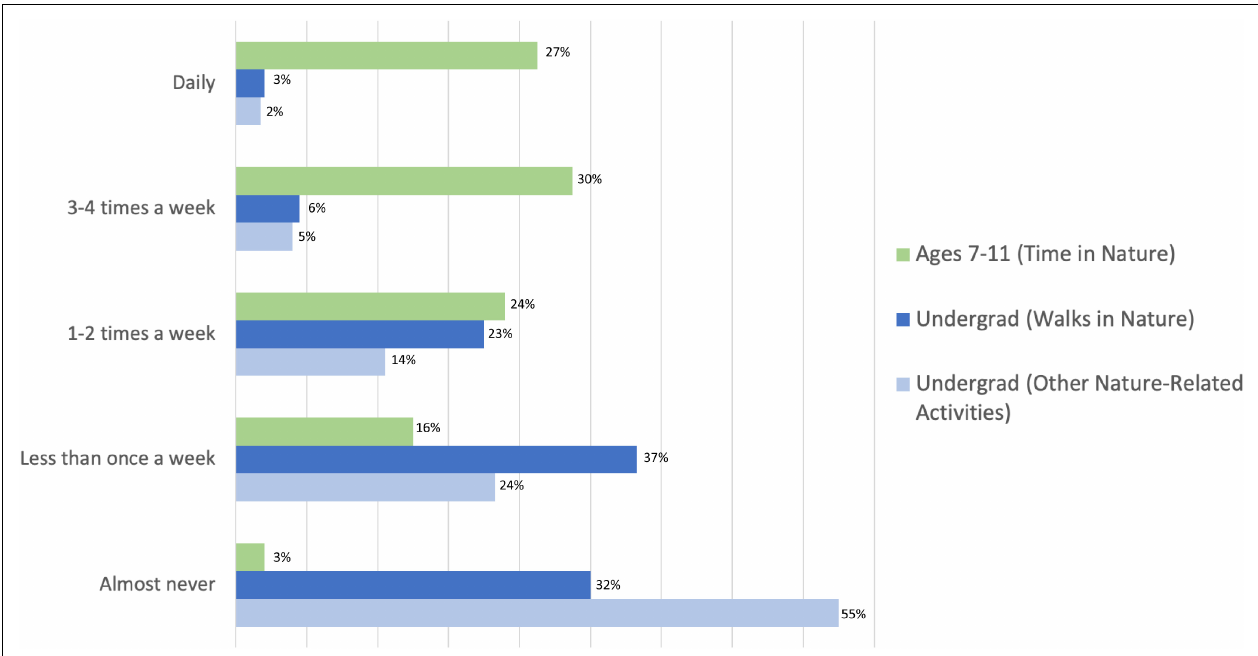
FIGURE 1 | Frequency of nature engagement decreases from childhood to undergraduate years. Supporting H1, participants who engaged with nature (NE) more frequently in MCYs engaged with nature more frequently as undergraduates (recreational walks, τ b = 0.223, p < 0.001, and other nature-related activities as undergraduates, τ b = 0.306, p < 0.001). Post hoc tests revealed that participants who engaged with nature daily in MCYs were more likely to engage with nature as undergraduates [take nature walks or engage in other nature-related activities one to two times a week (adjusted R = 3.1 and 4.3,